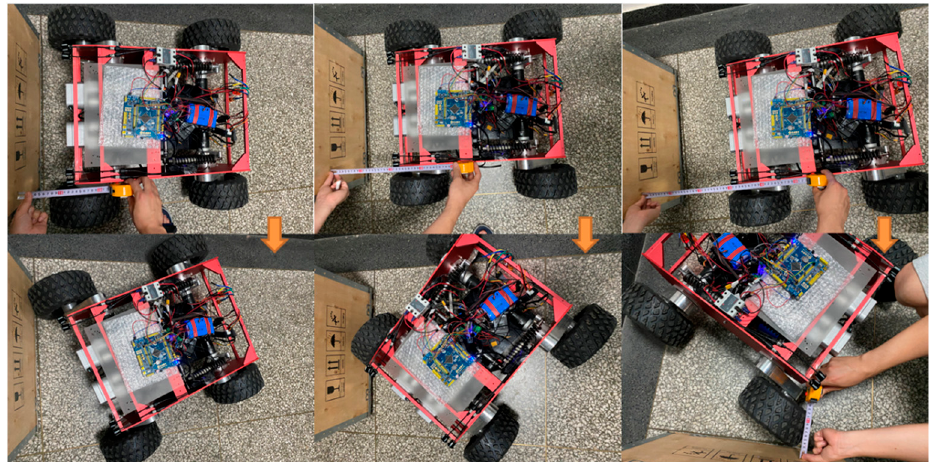
Figure 16. Obstacle avoidance and turning experiment of